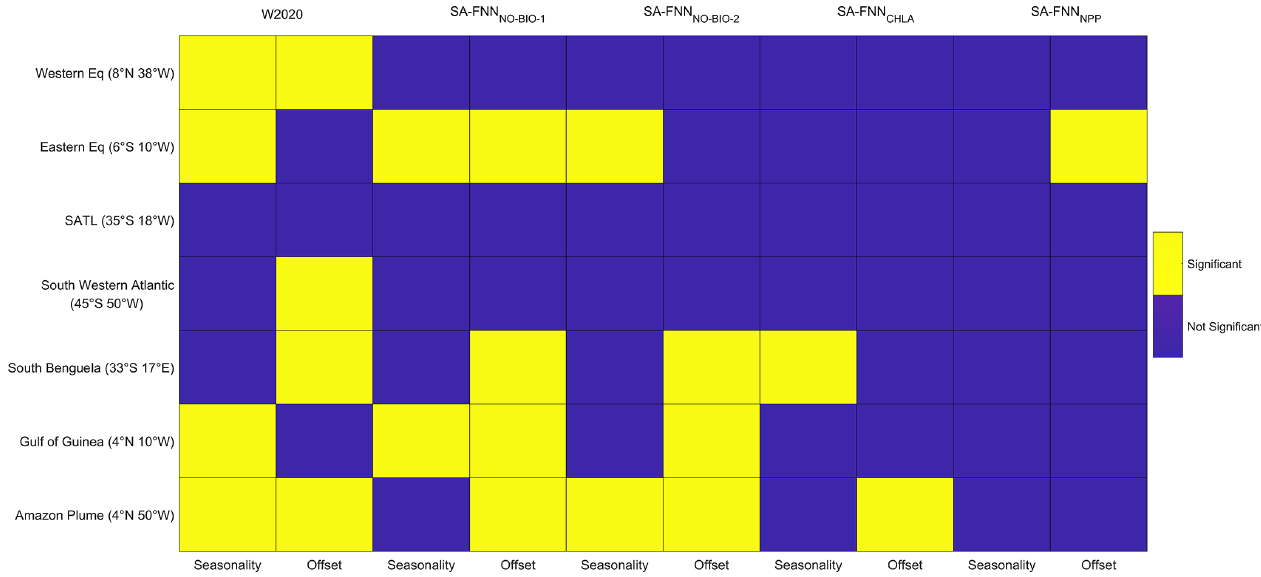
Figure 4. Statistical comparison of the SA-FNN NCP with the W2020, SA-FNN NO-BIO-1 , SA-FNN NO-BIO-2 , SA-FNN CHLA and SA-FNN NPP climatologies, where yellow blocks indicate a significant difference ( α = 0 . 05). Seasonality indicates a difference in the sea- sonal cycle, and offset indicates a difference between the mean p CO 2 ( sw ) of the